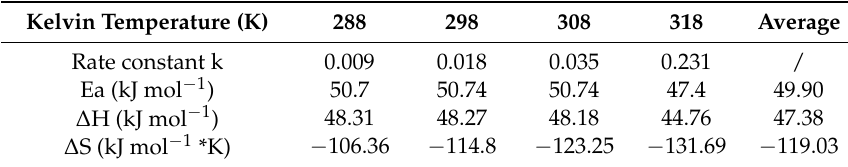
Table 1. Thermodynamic parameters for hydrolysis of FBEZF.